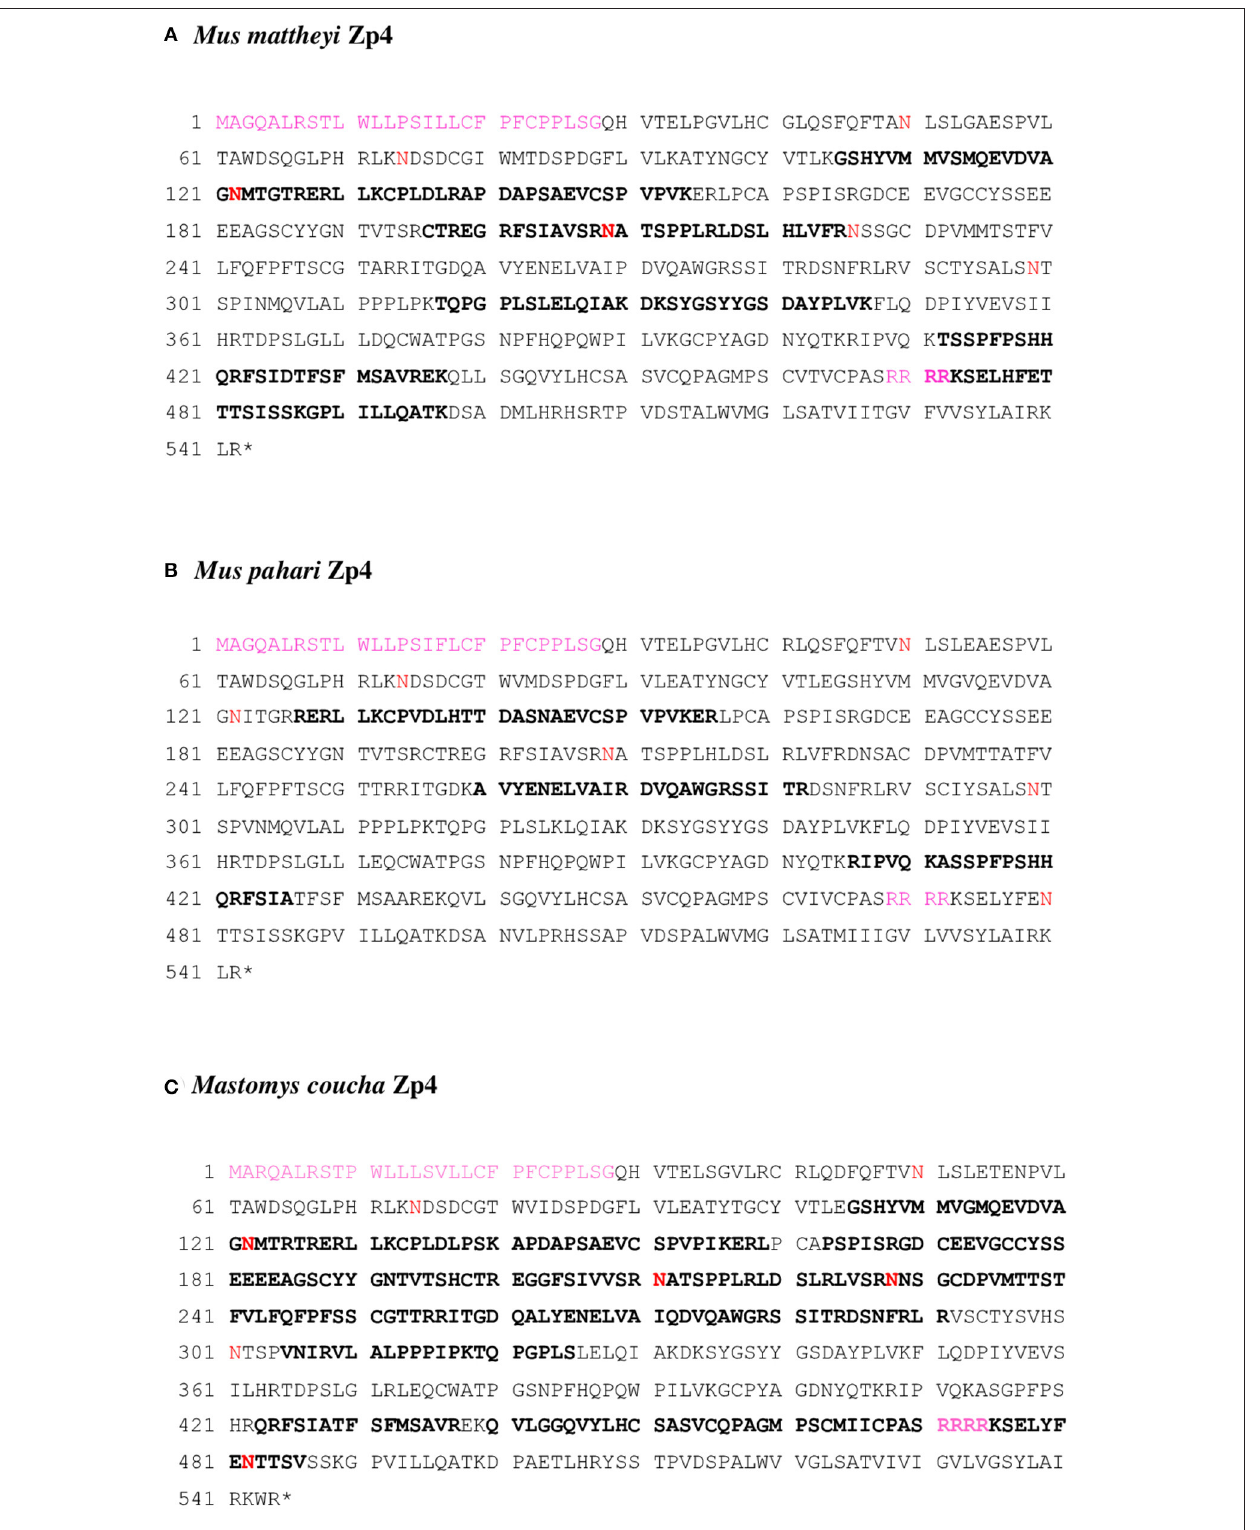
FIGURE 4 | (A) Mus mattheyi Zp4 (AYN07267.1), (B) Mus pahari Zp4 (AYN07268.1), and (C) Mastomys coucha Zp4 (XP_031215126.1) amino acid sequences. Bold sequences are the tryptic peptides obtained by MS/MS. The putative N-glycosylation sites are in red. The signal peptide and the furin cleavage site (Arg-Arg-Arg-Arg) are shown in